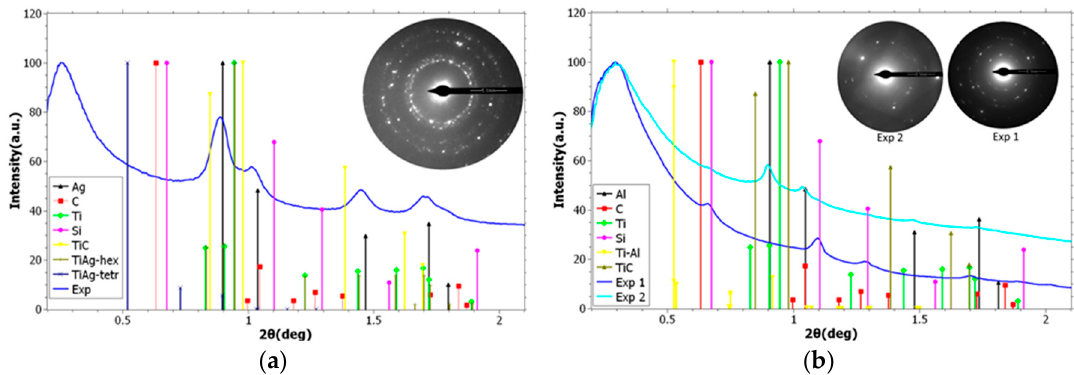
Figure 6. Radial distribution function and identified peaks in the profile of the Ti-C-Ag/Si ( a ) and Ti-C-Al/Si ( b ) films with SAED images (inset).